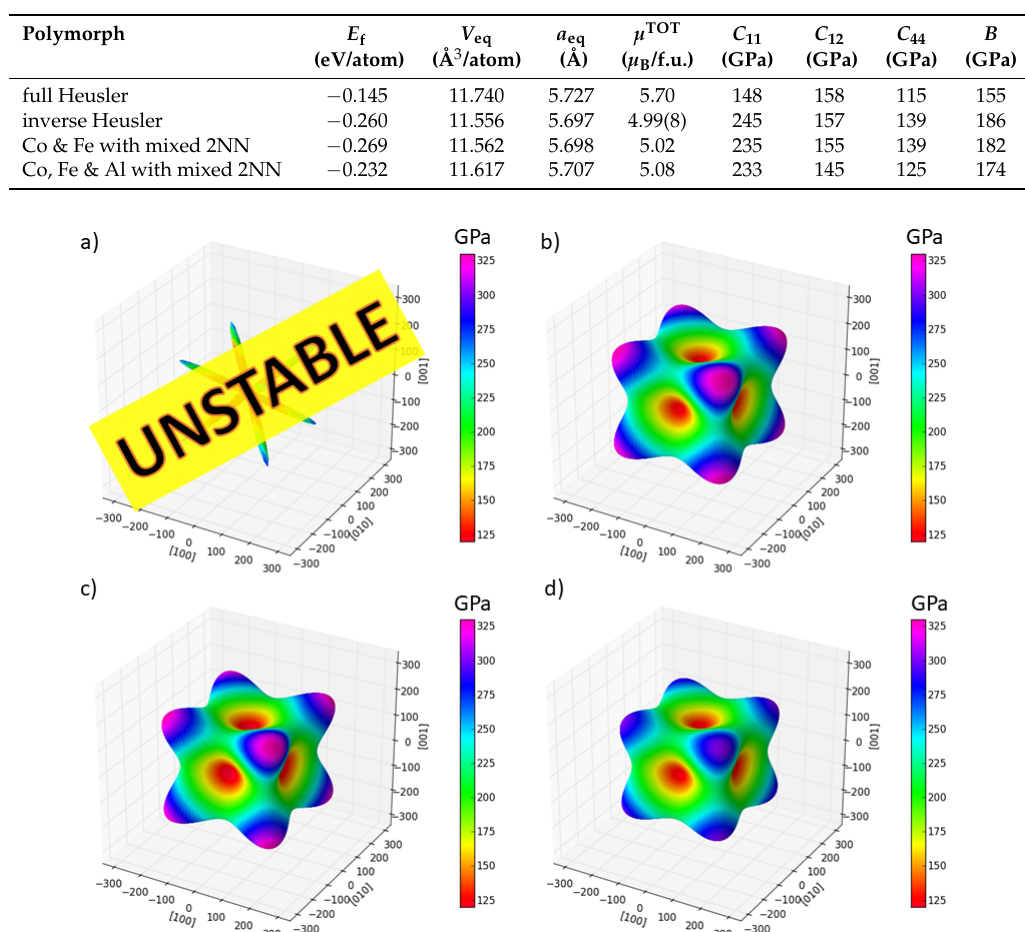
Figure 2. Visualizations of single-crystal elastic properties of Fe 2 AlCo polymorphs in the form of directional dependences of Young’s modulus for ( a ) the full-Heusler-structure variant, ( b ) inverse-Heusler polymorph, ( c ) specific distribution of Co (and Fe) atoms regarding the atoms in the 2NN shell (see the text), and ( d ) special arrangement of atoms of all three chemical species. The directional dependences were computed from the single-crystal elastic stiffnesses of the studied polymorphs and visualized by the SC-EMA on-line tool [36,37]